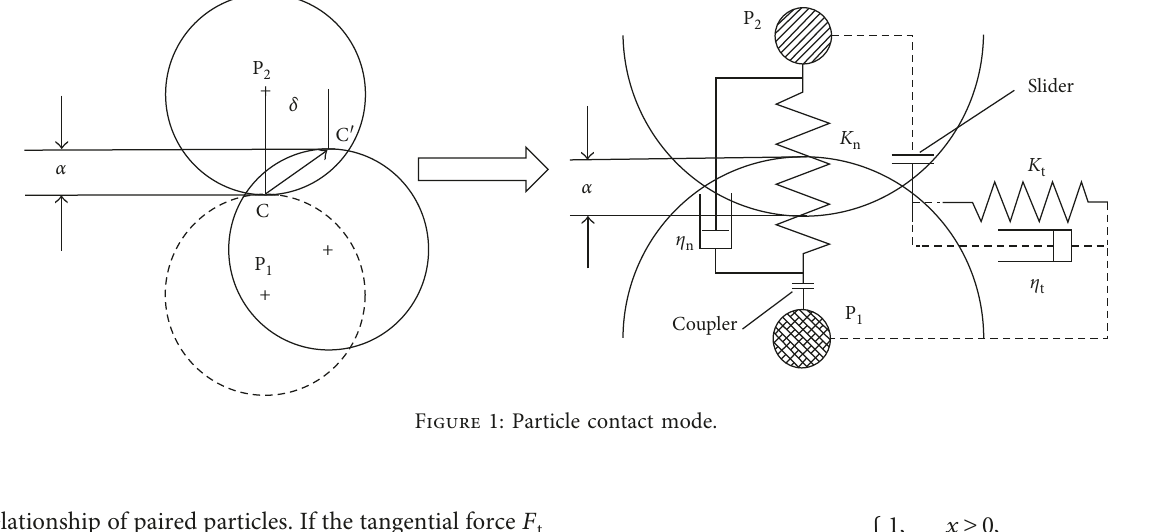
Figure 1: Particle contact